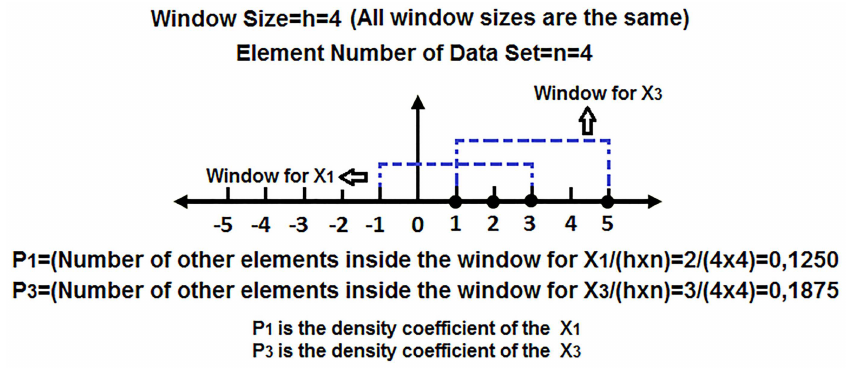
Fig 4. Calculation of the density coefficients for two elements in a sample